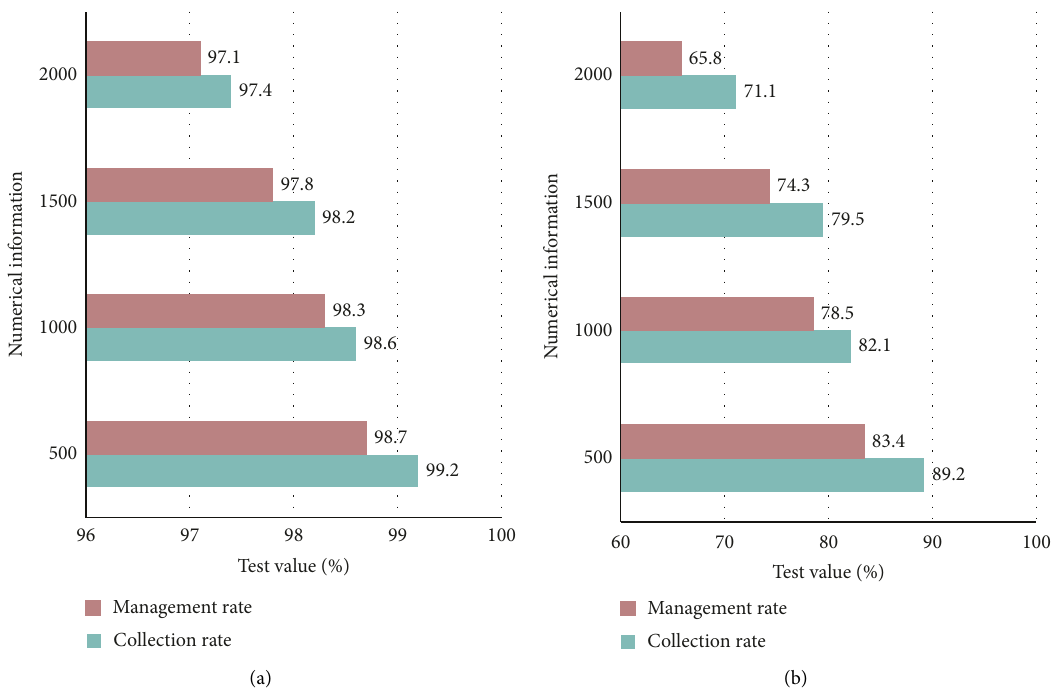
Figure 7: Data collection and management results. (a) The monitoring system of this study. (b) A traditional monitoring